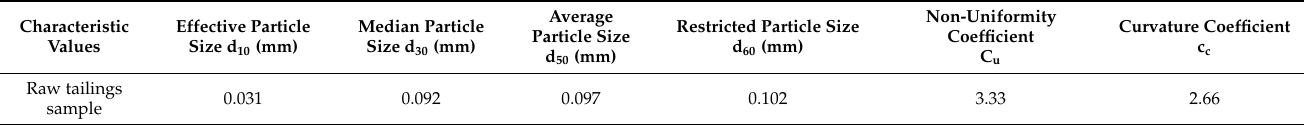
Table 2. The particle characteristics of raw tailings